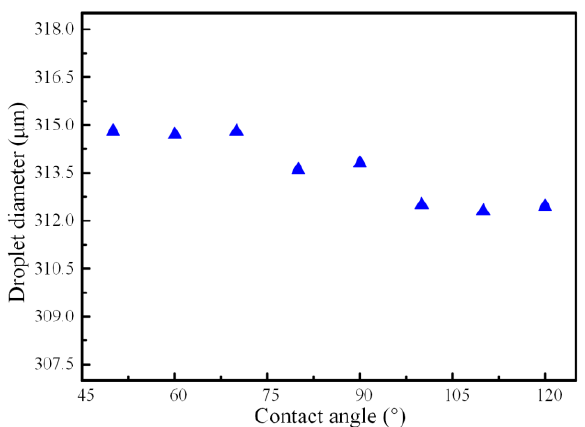
Figure 9. The effect of contact angle on the droplet diameter when the flowrates of the continuous phase and the dispersed phase were fixed at 100 µ L / min and 10 µ L / min, respectively.